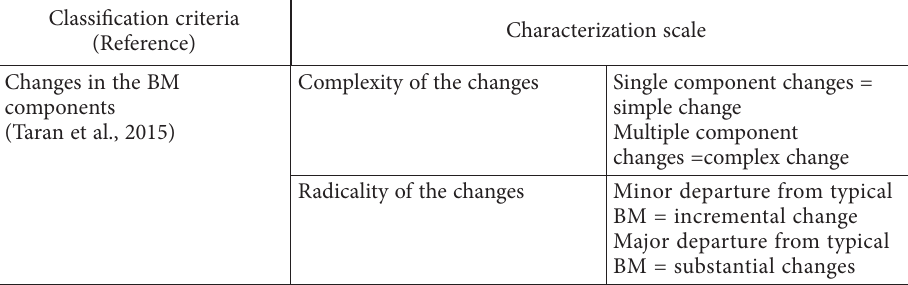
Table 2. Framework for characterization of the business model (BM) in creative professional services (CPSs) (source: created by authors) Classification criteria